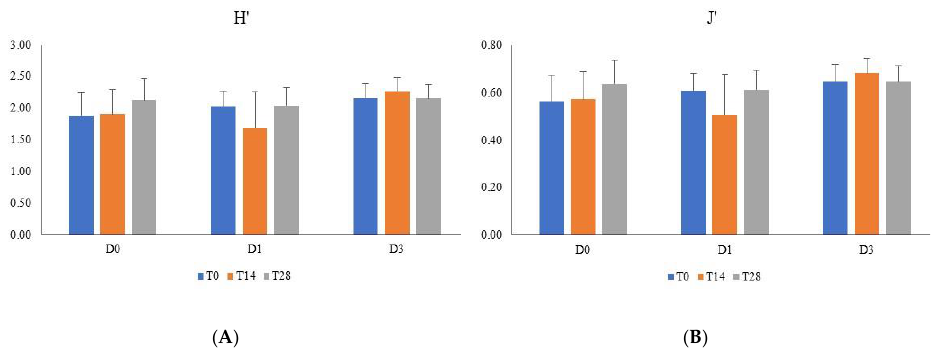
Figure 1. ( A ) Shannon index of biodiversity (H’) and ( B ) Evenness (J’) of the microbial communities for dietary treatments with increasing dose of grape proanthocyanidins. H’ and J’ were calculated on the relative abundances of genera in the feces of dogs fed a basal diet supplemented with increasing amount of grape proanthocyanidins (D0, D1, and D3). D0: Dogs without supplementation of proanthocyanidins; D1: Dogs supplemented with 1 mg / kg live weight of proanthocyanidins; D3: Dogs supplemented with 3 mg / kg live weight of proanthocyanidins. T0: beginning of the study; T14: after 14 days of the study; and T28: after 28 days of the